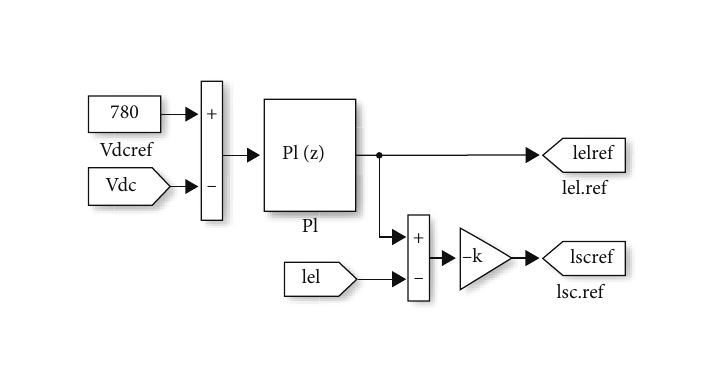
Figure 6: Coordinated control scheme of the electrolyzer and SC.